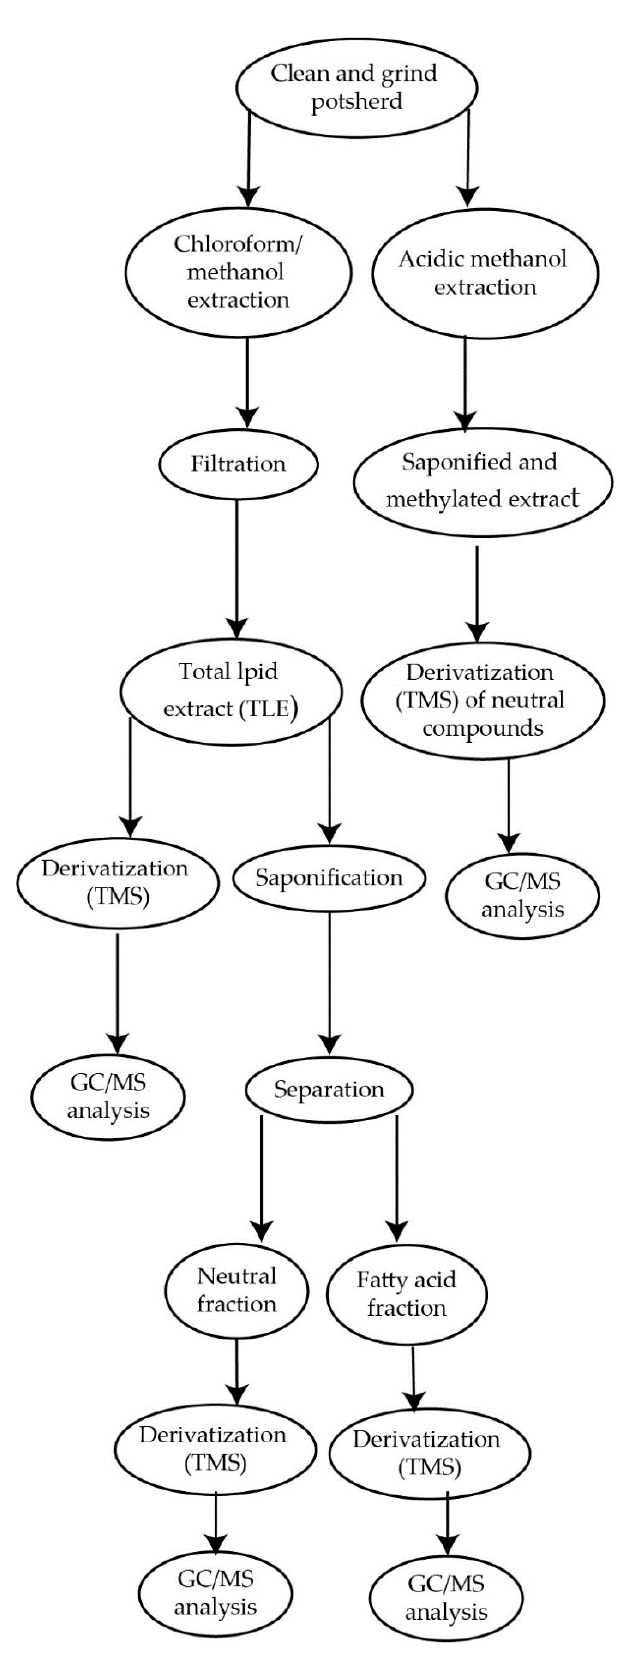
Figure 4. Analytical workflows of both conventional solvent extraction (chloroform/methanol) and direct extraction derivatization protocols. Reproduced with kind permission of MDPI [115].